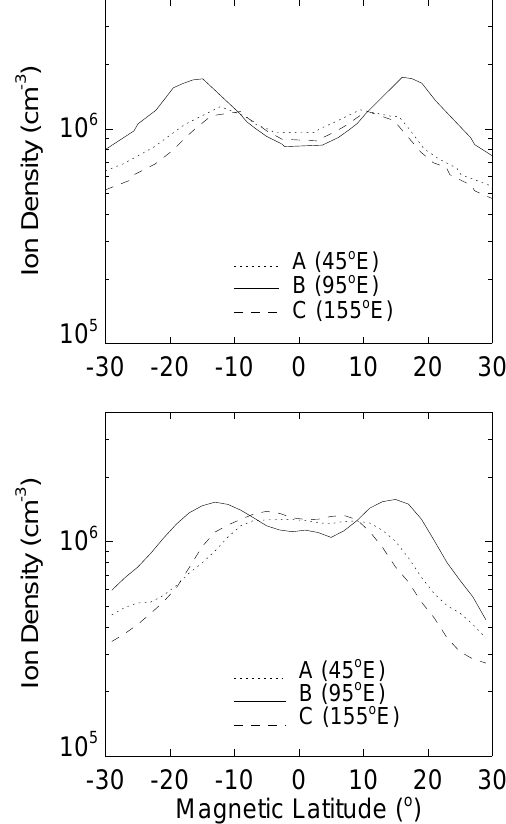
Fig. 5. The SAMI2 model plasma density profiles at an altitude of 600km at 12:00–14:00LT on 26 March 2002 calculated using the ROCSAT-1 drift data shown in Fig. 4 (top). The bottom panel shows the ROCSAT-1 density profiles at the three locations obtained from Fig. 1.